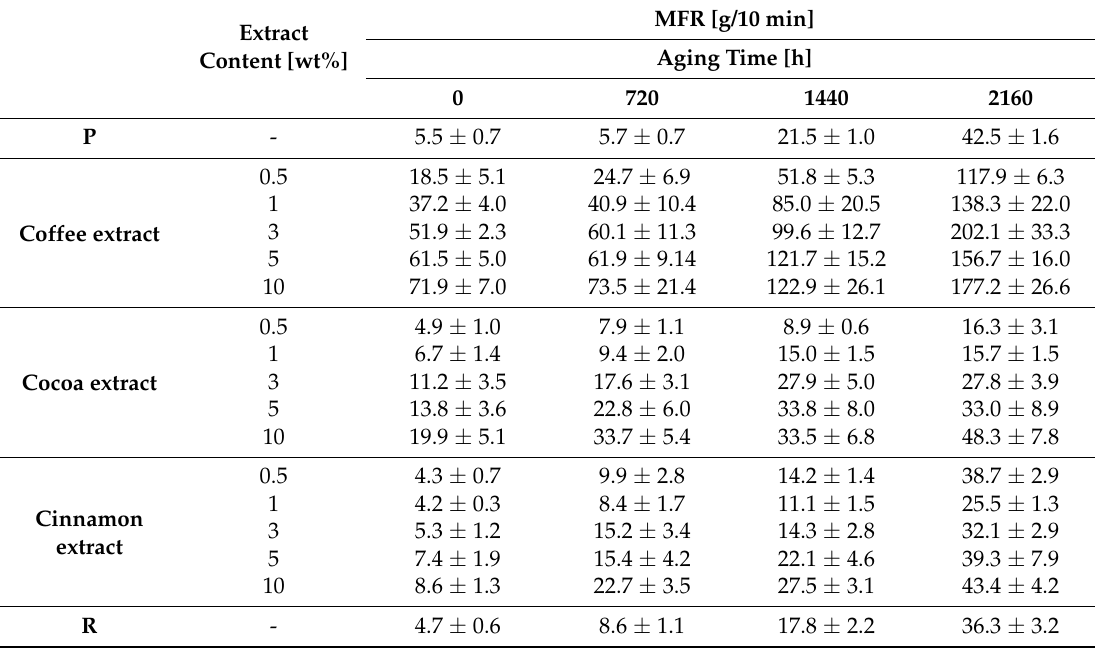
Table 1. The test results of melt flow rate